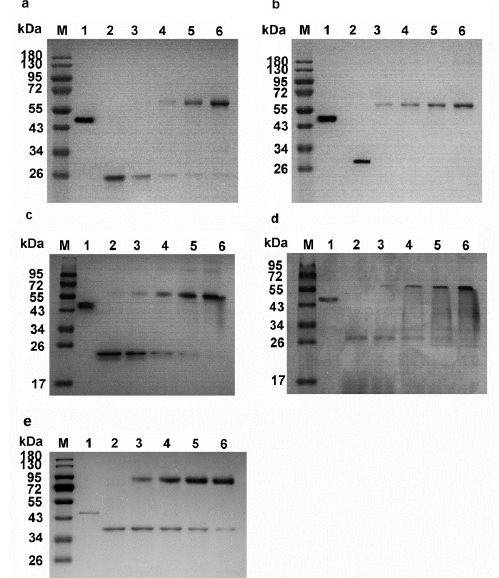
Figure 6. SDS-PAGE analysis of stable covalent complexes of Pnserpin with serine proteases. ( a ) CHT